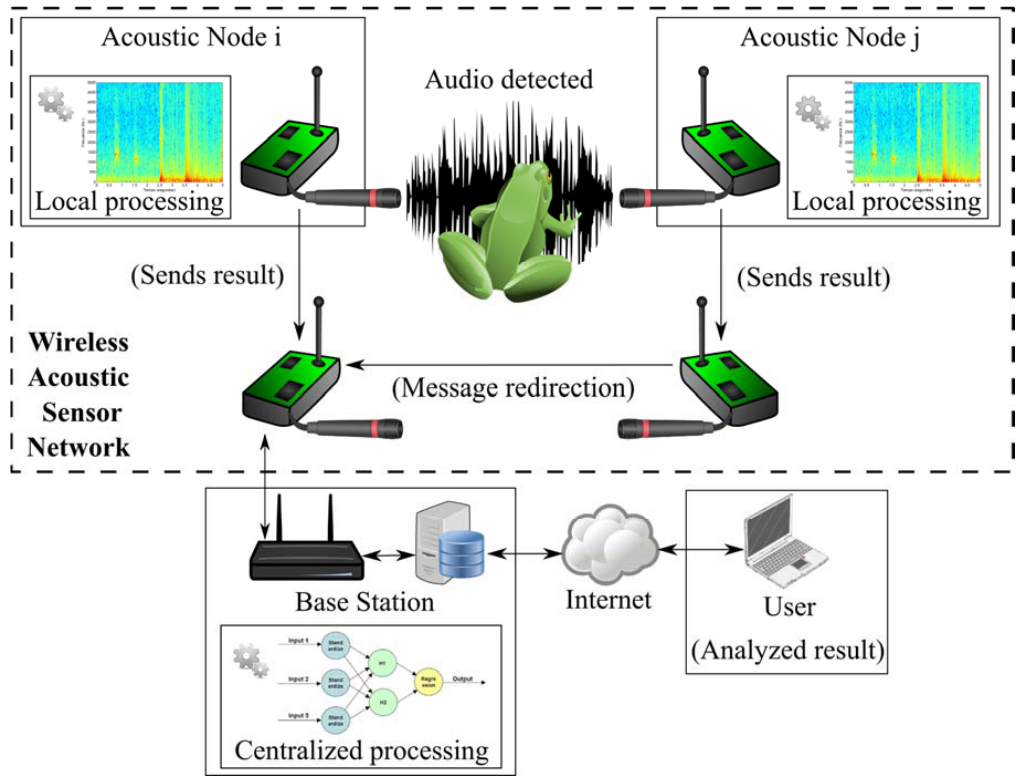
Figure 1. Architecture of the proposed Wireless Acoustic Sensor Network.